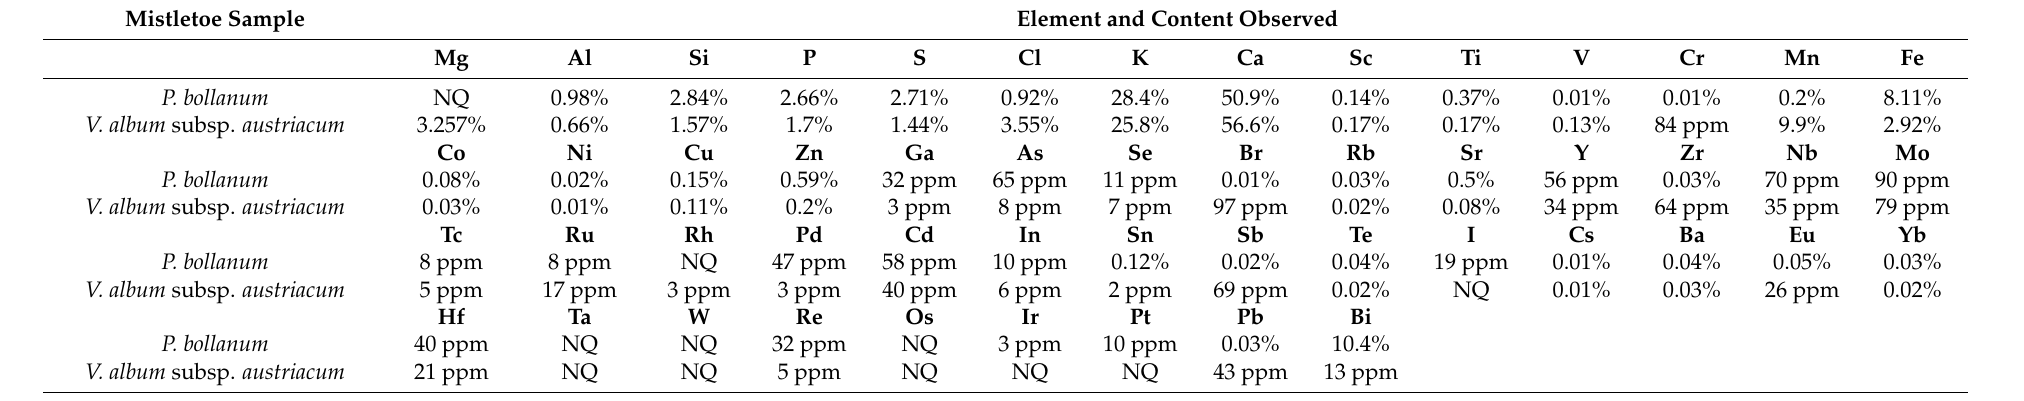
Table 1. Concentrations of minerals presented P. bollanum and V. album subsp. austriacum quantified by the X-ray fluorescence elemental analysis expressed as a percentage ( w / w ) and in parts per million (ppm) in the total amount of